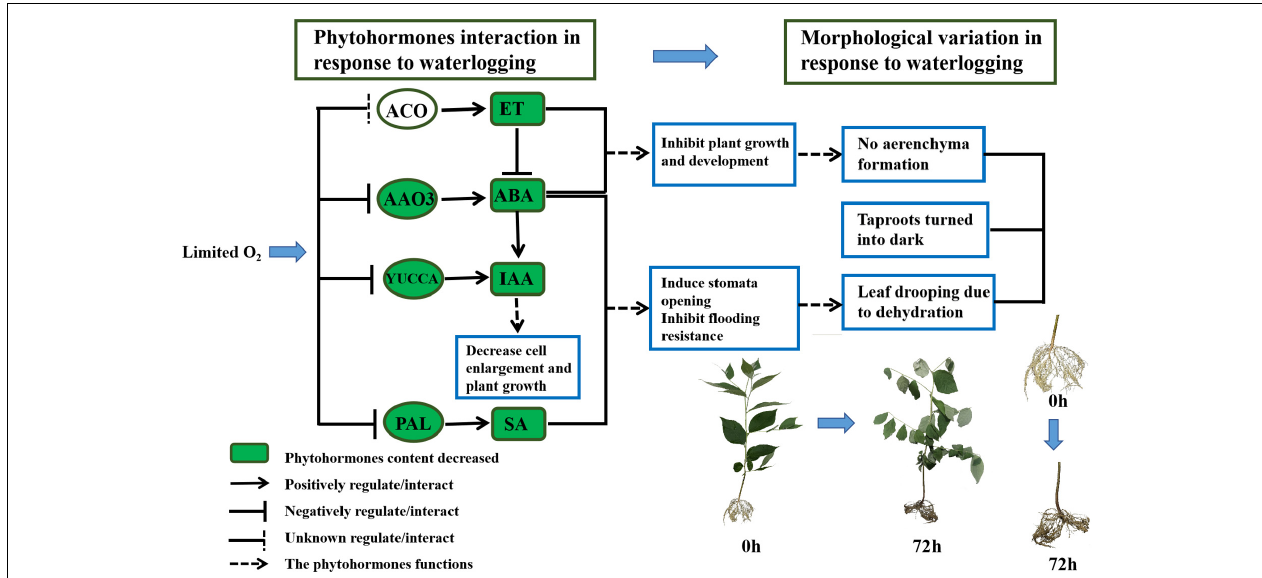
FIGURE 7 | Schematic diagram of phytohormones crosstalk (72 vs. 0 h) and morphological variation (72 vs. 0 h) in response to waterlogging in Styrax tonkinensis seedlings. Different lowercase letters within each graph indicate significant differences ( p < 0.05) among the samplings.